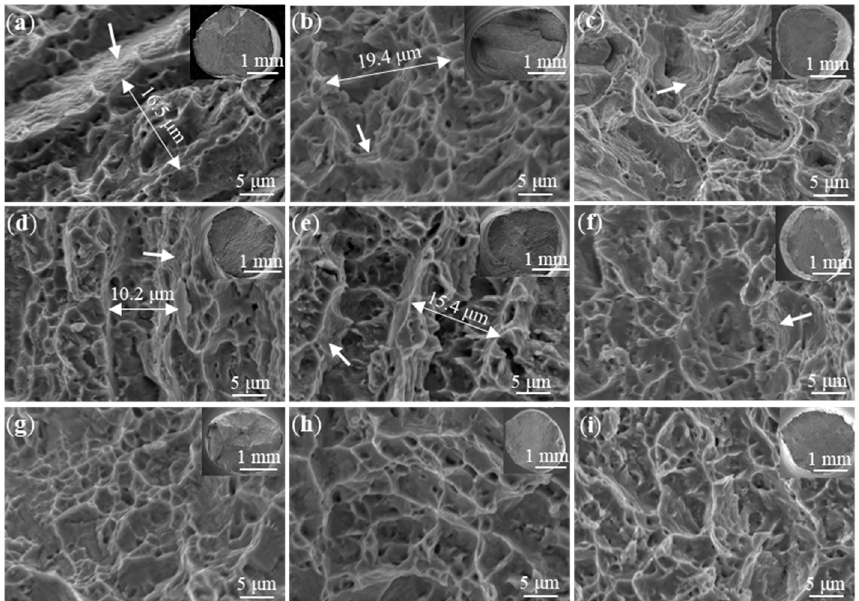
Figure 17. Fracture surfaces of tensile samples: ( a ) U2-H2, ( b ) U2-H4, ( c ) U2-V2, ( d ) C3-H2, ( e ) C3-H4, ( f ) C3-V2, ( g ) U3-H2, ( h ) U3-H4, ( i ) U3-V2. (The white arrow indicates the characteristics of slip separation).